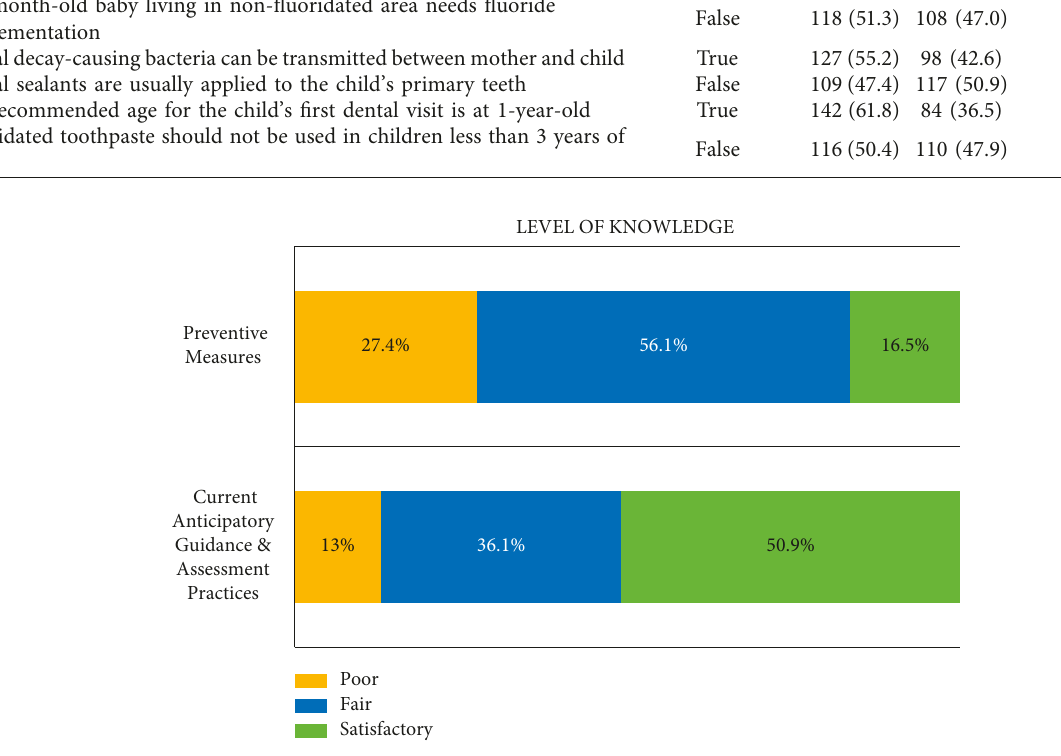
Figure 2: Participants’ level of knowledge (%) on preventive measures and current anticipatory guidance and assessment practices. Table 3: Current anticipatory guidance and assessment practices on the role of pediatricians in promoting oral health. At a well-childcare visit in your practice, do you likely perform the